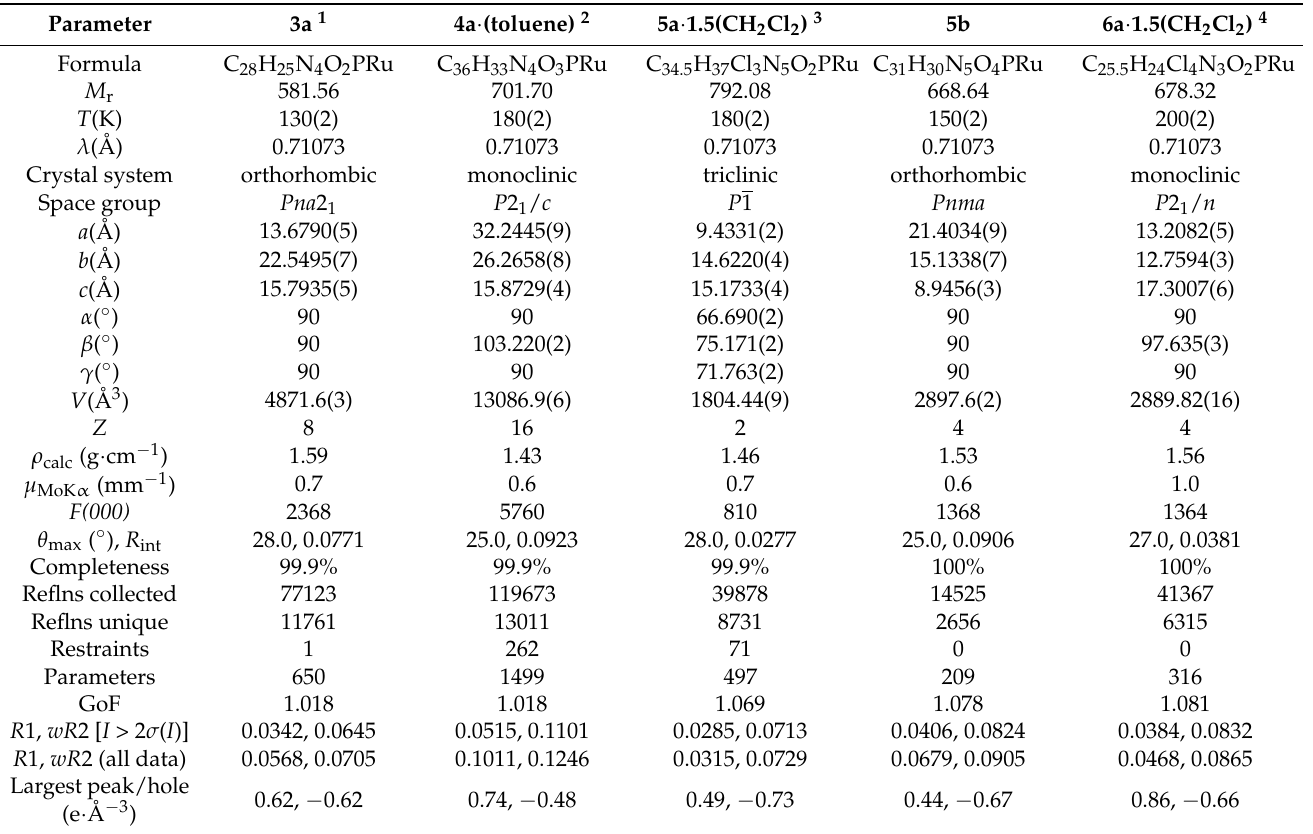
Table A1. Crystallographic data from data collection and refinement processes for 3a , 4a ·